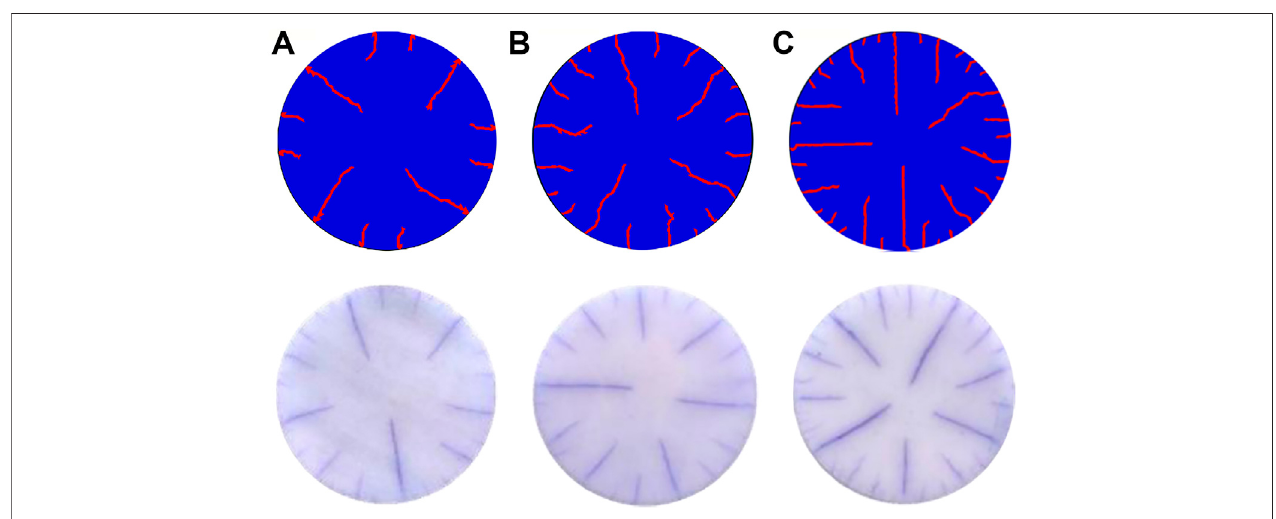
FIGURE4| Comparisonofsimulationresultsandexperimentalresults(Liuetal.,2015)ofthermalshockincircularAl 2 O 3 specimensatdifferentinitialthermalshock temperatures ( (A) T 0 (cid:1) 300 ° C, (B) T 0 (cid:1) 400 ° C, (C) T 0 (cid:1) 500 ° C).